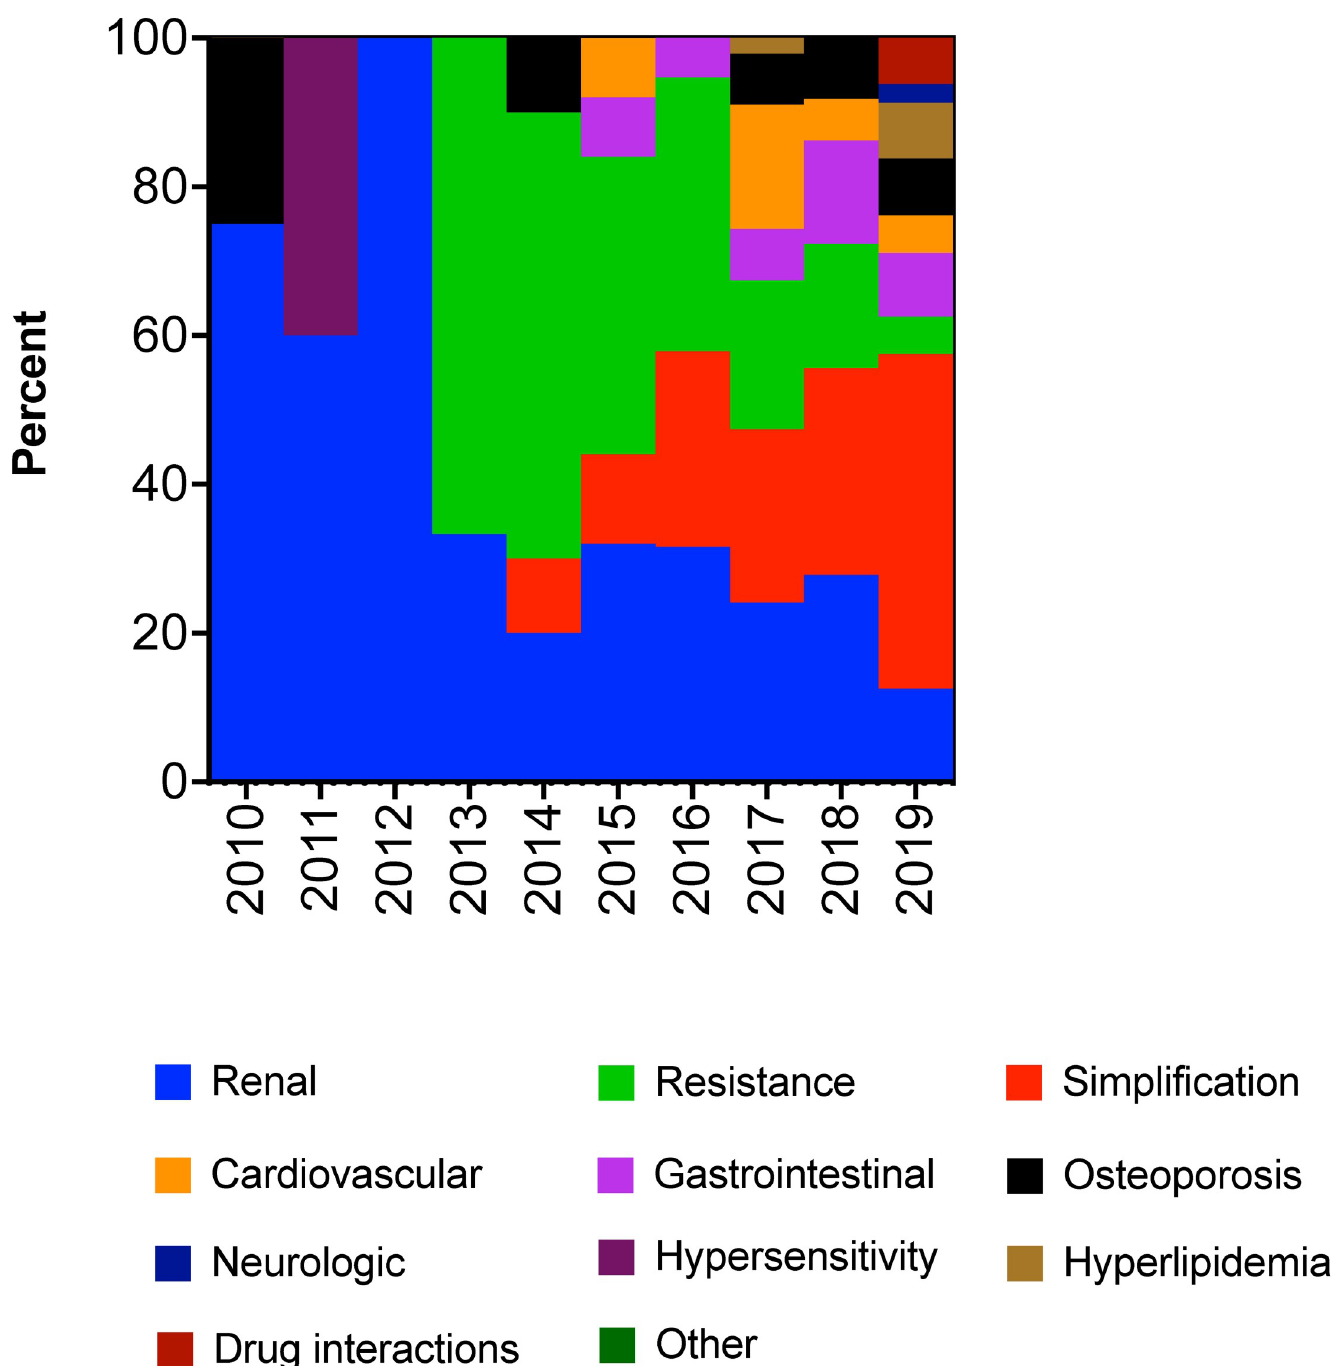
Fig 2. Reasons for 2DR initiation by indication. Each indication is represented as the percent of patients that were switched due to this indication in each year from 2010–2019. Some patients had more than one indication for 2DR switch.